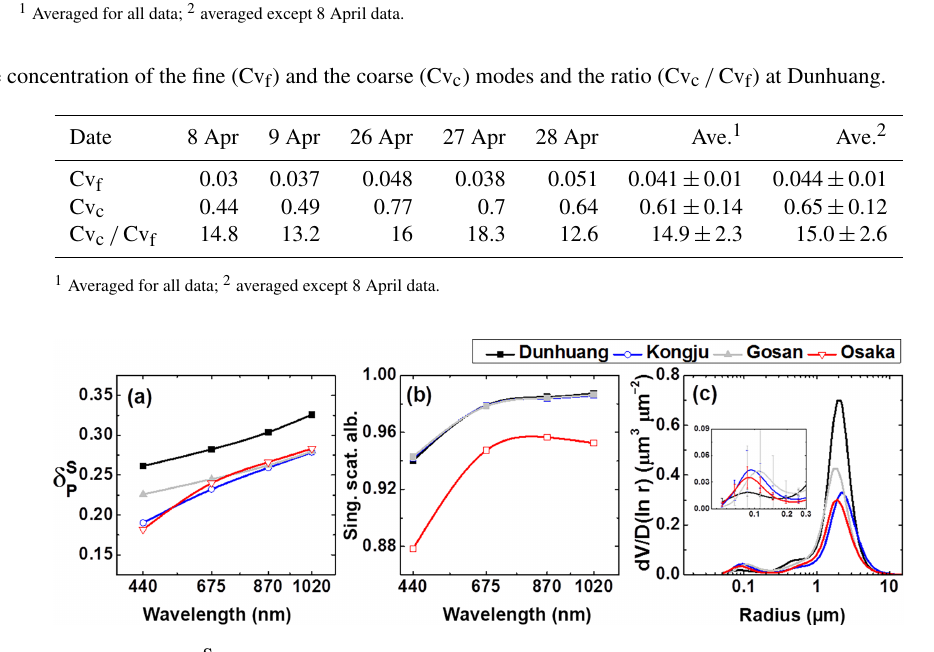
Figure 11. Comparison between (a) δ S , (b) SSA, and volume particle size distributions representing the dust source region (Dunhuang, P black) and group 6 data (Kongju, blue; Gosan, gray; Osaka,